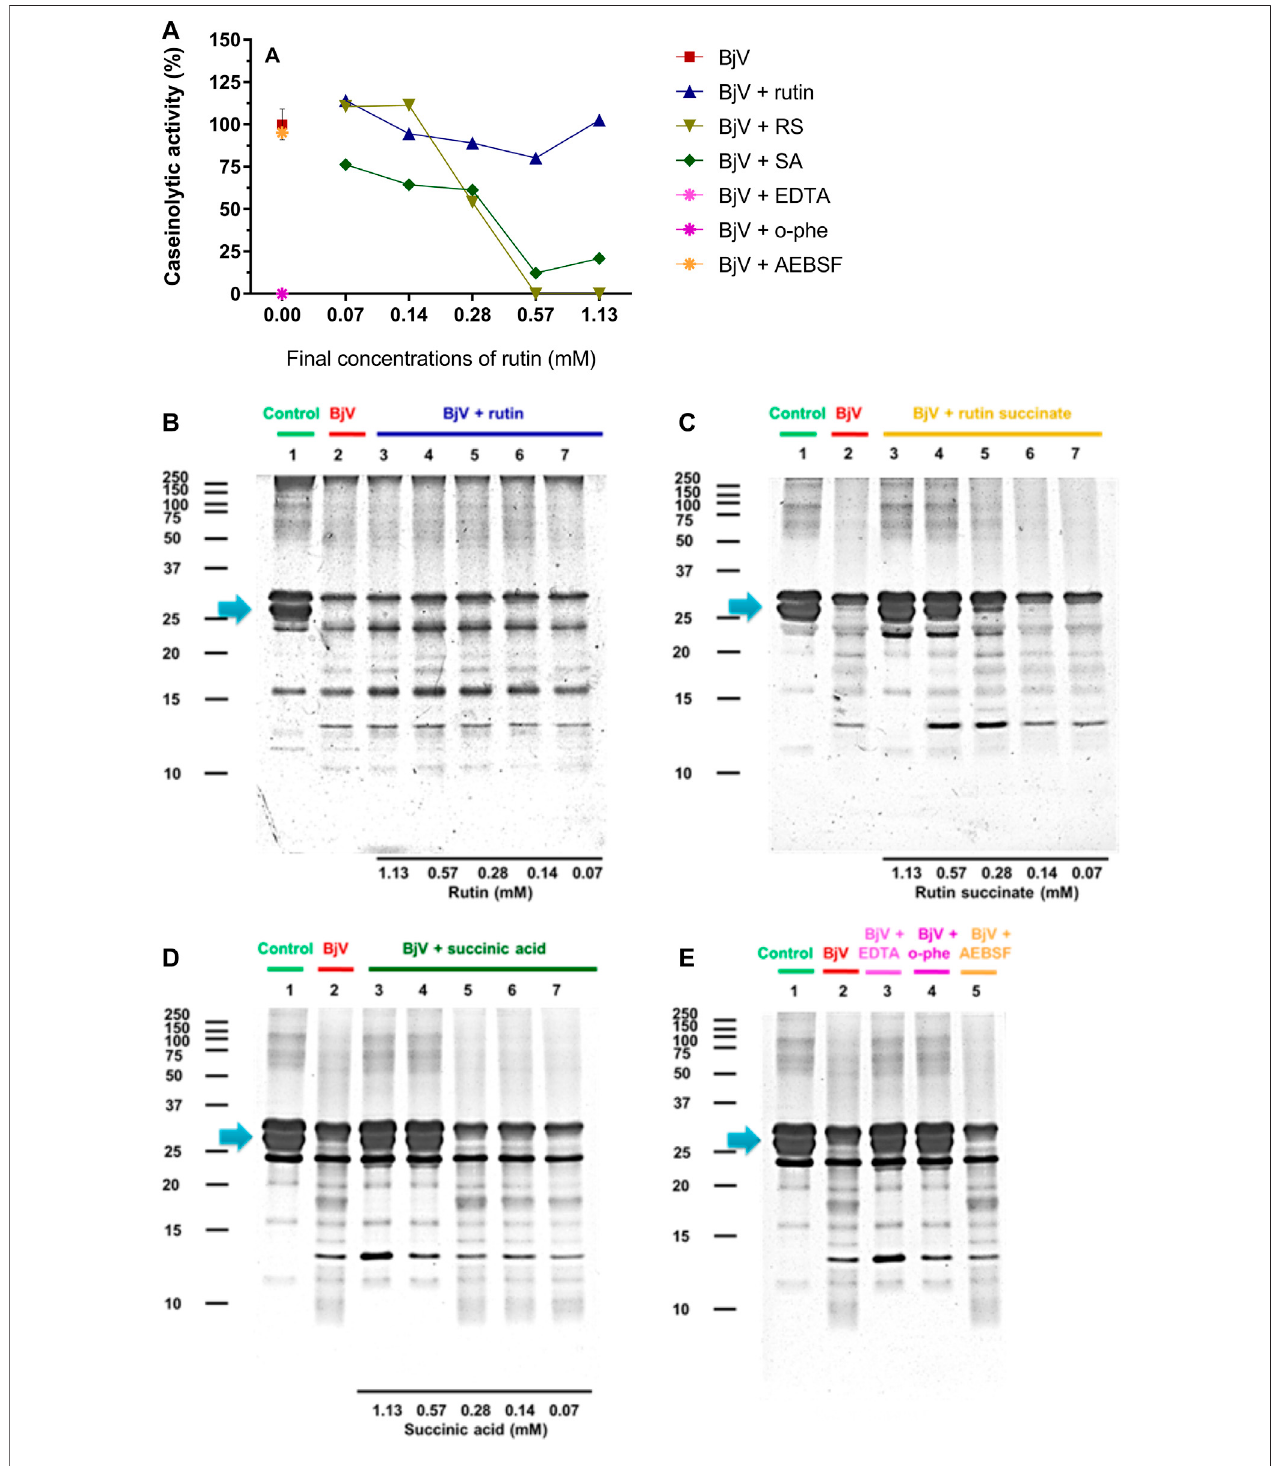
FIGURE 9 | (A – D) Activity of rutin, RS and SA at different concentration on BjV-induced caseinolytic activity in vitro . (A) data were expressed as percentage of caseinolyticactivity inducedbyBjV alone; (B – E) casein degradation byBjV evaluatedbymeansofSDS-PAGE gels(10%).Casein incubated withoutBjV(lanes1) orwith BjV solutions at 1.0 mg/ml (lanes 2); [ (B) , BjV + rutin], lanes 3 – 7, rutin concentrations ranging from 1.13 to 0.07 mM; [ (C) , BjV + RS], lanes 3 – 7, RS concentrations ranging from 1.13 to 0.07 mM; [ (D) , BjV + SA], lanes 3 – 7, SA concentrations ranging from 1.13 to 0.07 mM; (E) BjV + Na 2 EDTA (lane 3), BjV + o-phe (lane 4) and BjV + AEBSF (lane 5). Arrows refer to interest bands of 25 kDa – 30 kDa (approximately), relative to non-degraded α -casein.